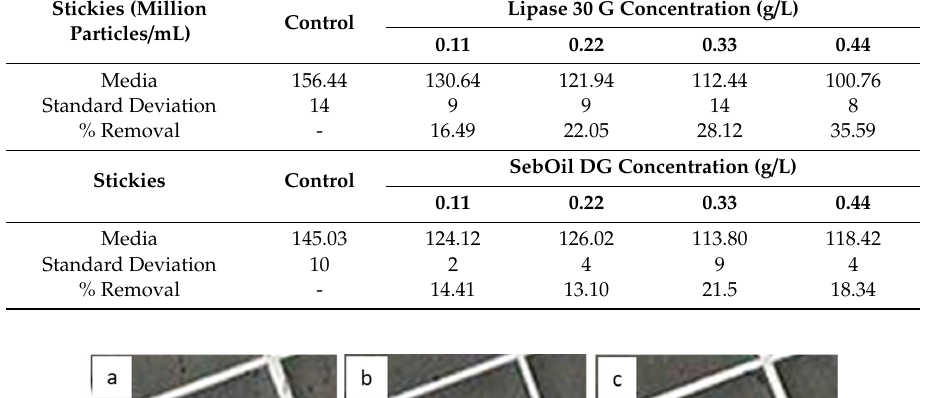
Table 4. Mean stickies present in the samples after the enzyme treatment with the enzyme Lipase 30 G and SebOil DG at di ff erent concentrations.